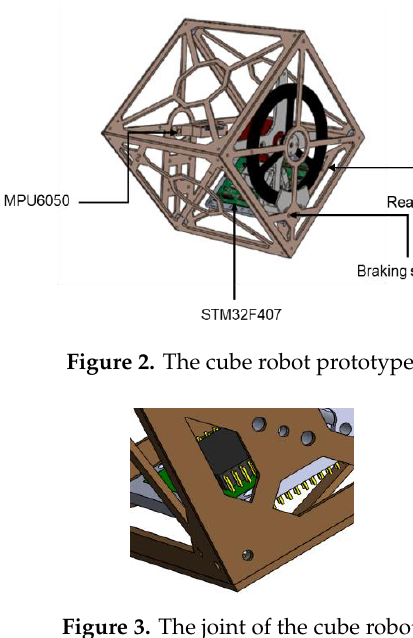
Figure 3. The joint of the cube robot.